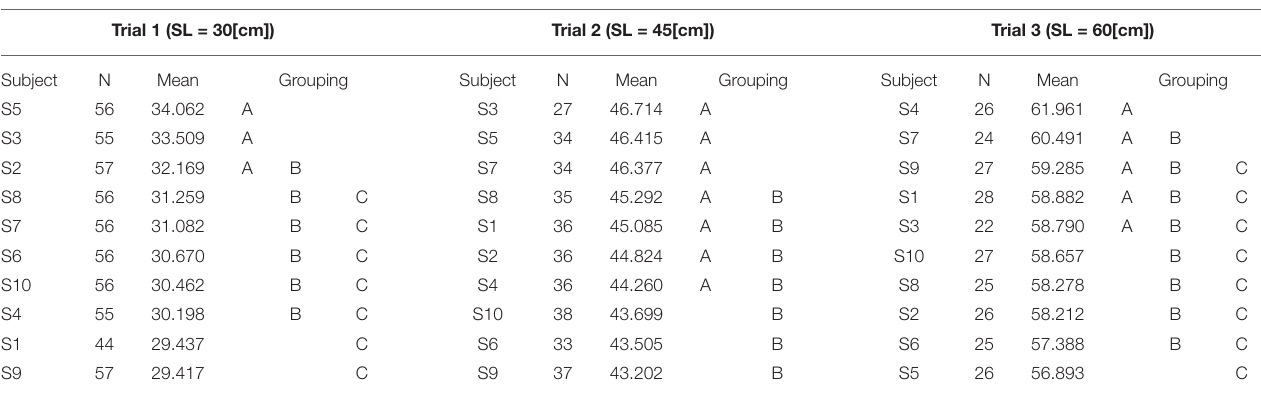
TABLE 3 | Grouping using the tukey method and 95 % confidence for step length